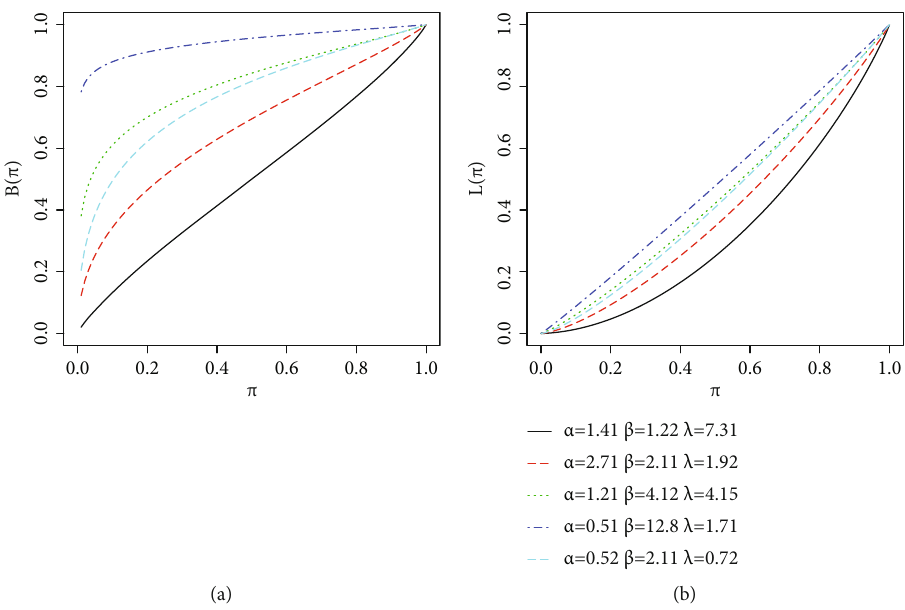
Figure 6: Plot of (a) Bonferroni curve and (b) Lorenz curve of UPWD for some parametric